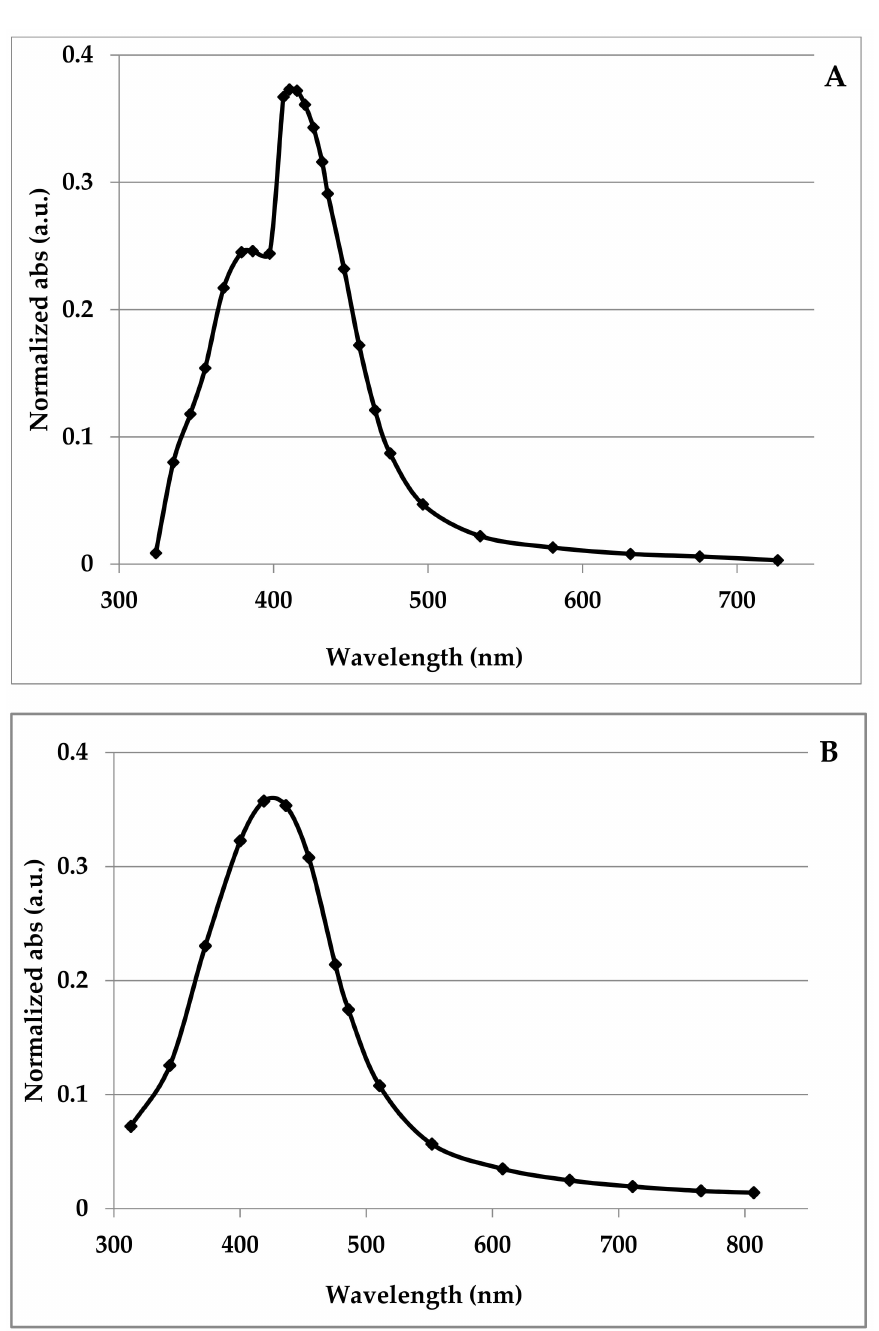
Figure 1. Ultraviolet-visible absorption spectra of the AgNPs solution. ( A ) immediately after nanopar- ticle synthesis; ( B ) after a